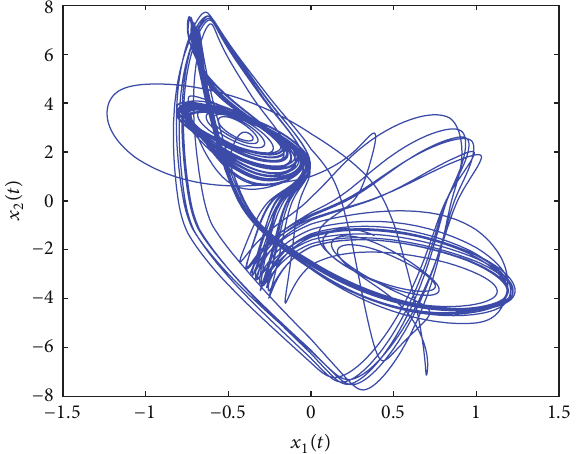
Figure 5: Trajectory of system (25) with initial value 𝑥(𝑡) = (−0.5, 1.5) 𝑇 and 𝑢(𝑡) = 0 , 𝑡 ∈ [−1,0] .